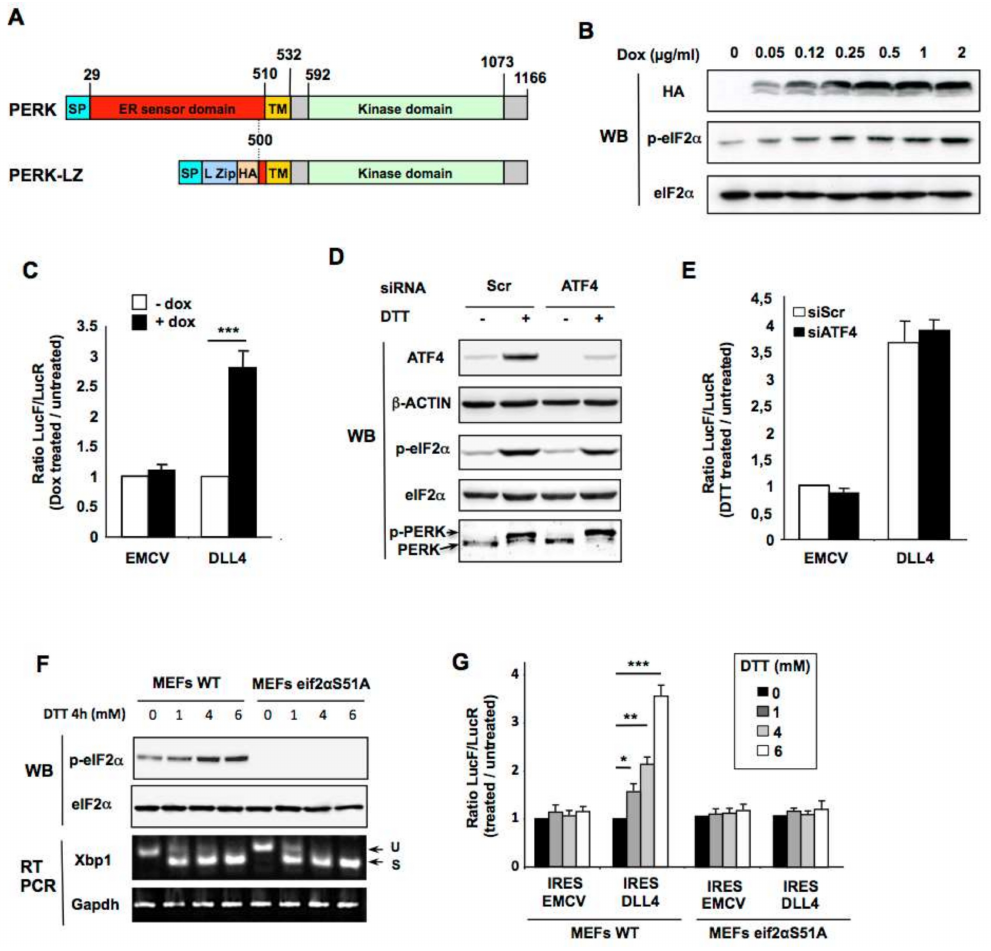
Figure 5. PERK kinase activity stimulates DLL4 IRES-mediated translation in a phosphorylated eIF2 α –dependent manner. ( A ) Linear schematic representation of PERK and PERK-LZ showing the locations of the major functional domains (SP = Signal Peptide, L zip = Leucine Zipper, HA = HA Tag). Numbers indicate amino acid positions. ( B ) Western blot analysis of doxycycline-induced-PERK-LZ (HA) expression and eIF2 α phosphorylation after 48 h treatment with increasing amounts of doxycycline. ( C ) Relative IRES activities in PERK-LZ expressing HeLa cells treated with 1 µ g/mL doxycycline /control after transfection of EMCV or DLL4 bicistronic vectors. Means ± SEM are shown, *** p < 0.001. ( D ) Western blot analysis of ATF4, total and phosphorylated eIF2 α , as well as total PERK in HeLa cells, after transfection with ATF4 or scramble (Scr) siRNA and treatment with DTT. β -ACTIN was used as a loading control. ( E ) Relative IRES activities in HeLa cells treated with DTT/control, after cotransfection with the EMCV or DLL4 bicistronic vectors and with either siRNA specific for ATF4 or control siRNA (Scr). Results represent the means of three independent experiments ± SEM. ( F ) Wild-type (WT) and eIF2 α S51A MEFs transfected with the bicistronic LucR-IRES-LucF vectors and treated with increasing concentrations of DTT. ER stress induction was verified by monitoring eIF2 α phosphorylation by western blot and cytoplasmic XBP1 splicing by RT-PCR. ( G ) Relative IRES activities were determined as previously described in WT (left) and eIF2 α S51A (right) MEFs. Results represent the means of three independent experiments ± SEM, * p < 0.05, ** p < 0.01, *** p <